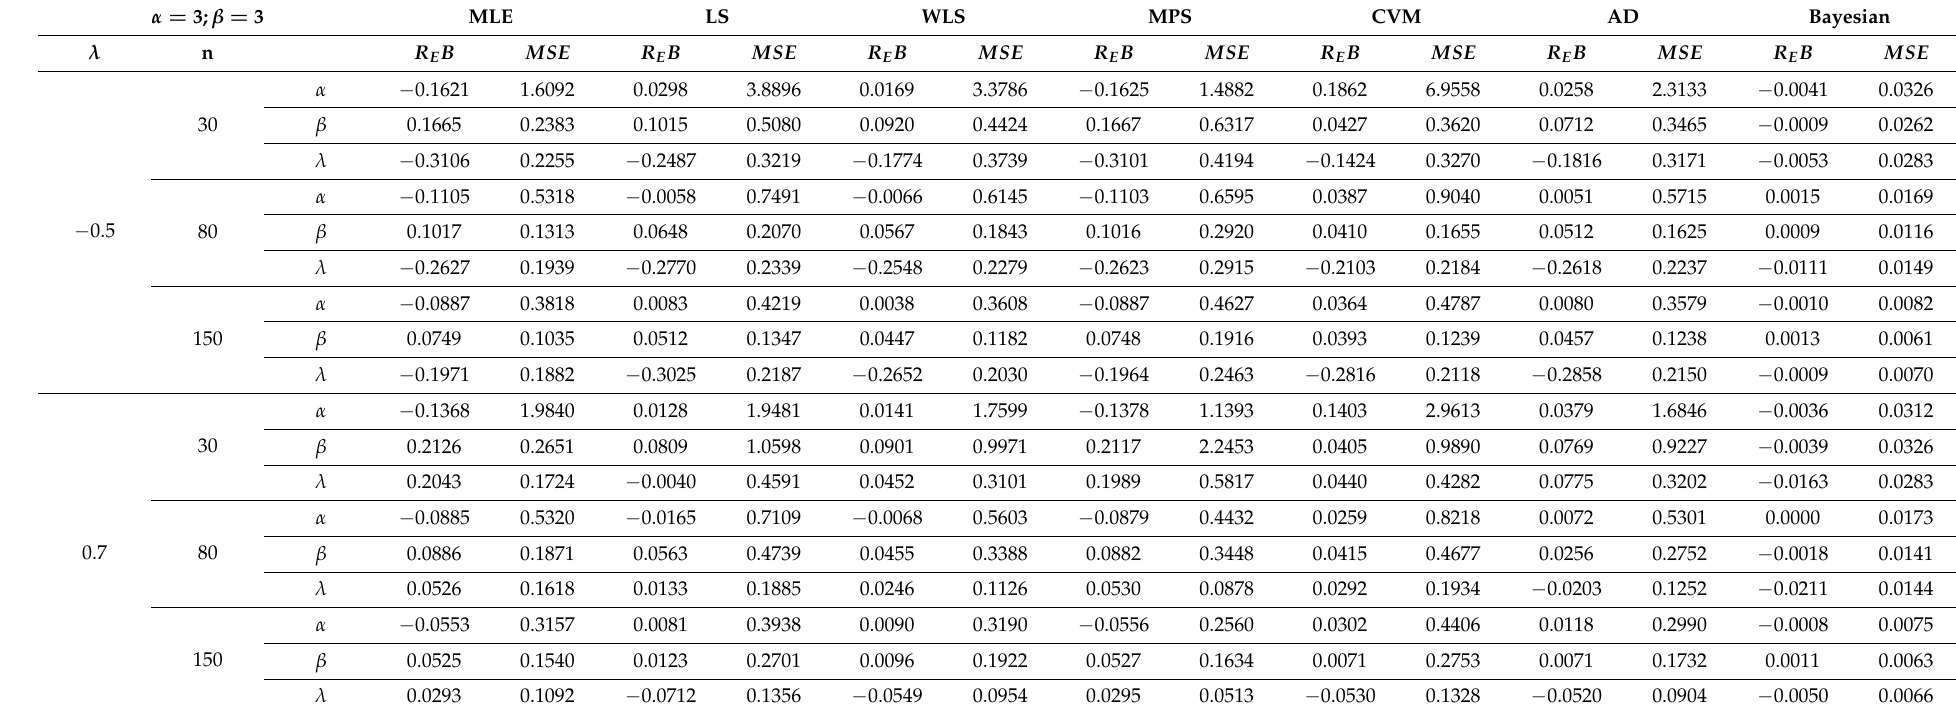
Table 5. Numerical outcomes of R E B and MSE for all estimation approaches at Case